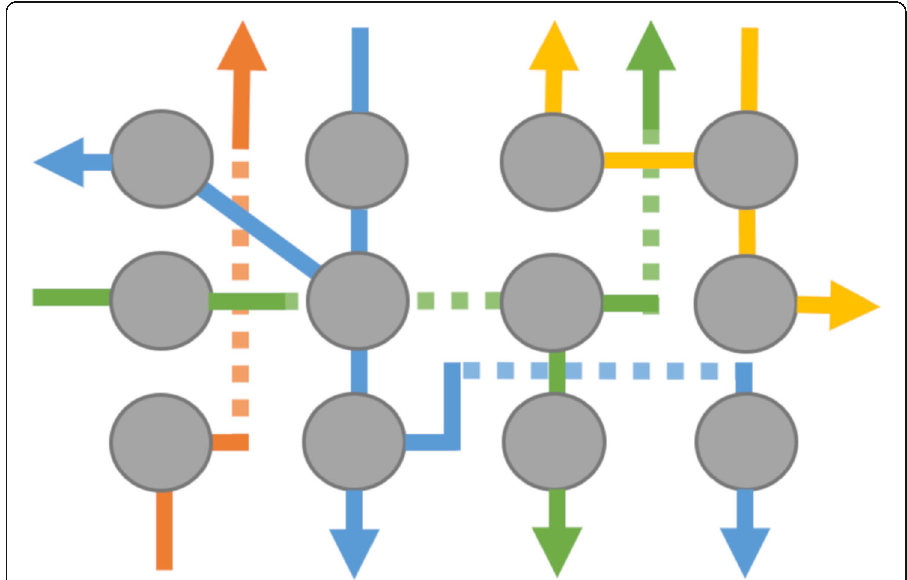
Fig. 4 Illustration of the parallel fluidic architecture running on both sides of the same layer (doted lines on the opposite side), thus enabling contamination free crossing of fluid